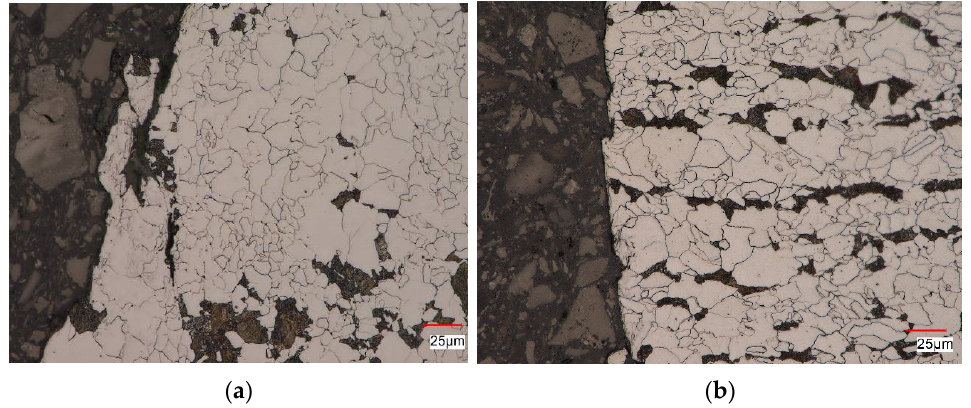
Figure 20. Structure of S420M steel after fatigue test at ε ac = 0.35%: ( a ) non-pre-deformed sample, ( b ) pre-deformed sample (10%).